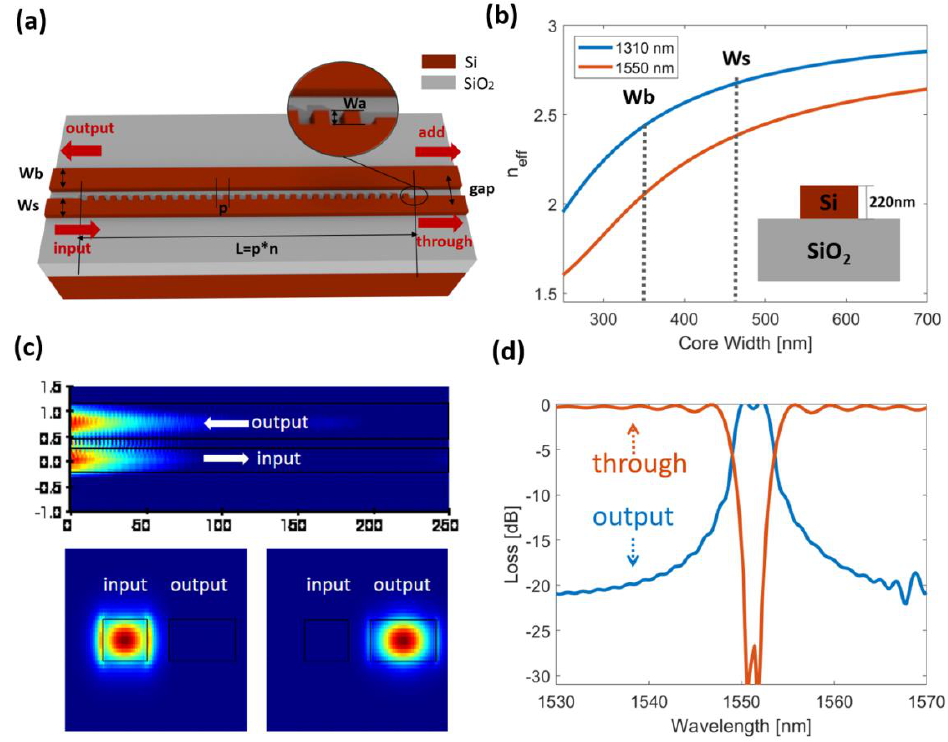
Figure 2. ( a ) Structure of a single reverse − coupled SWG wavelength division device. ( b ) Variation of effective refractive index with width for 220 nm thick strip waveguides in O − band and C − band. ( c ) Optical field map of the grating with a central wavelength of 1550 nm. ( d ) Losses at the through and output ends of the 1550 nm center wavelength grating.